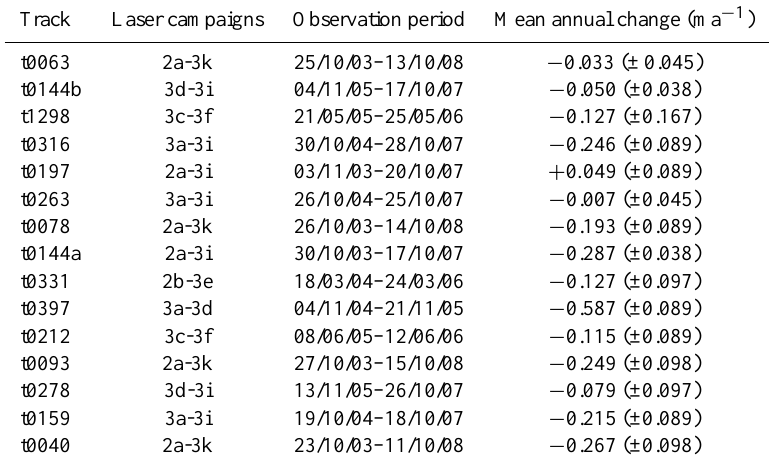
Table 3. Mean elevation change for each ICESat GLAS track over GVIIS. See Fig. 8 for location. Track Laser campaigns Observation